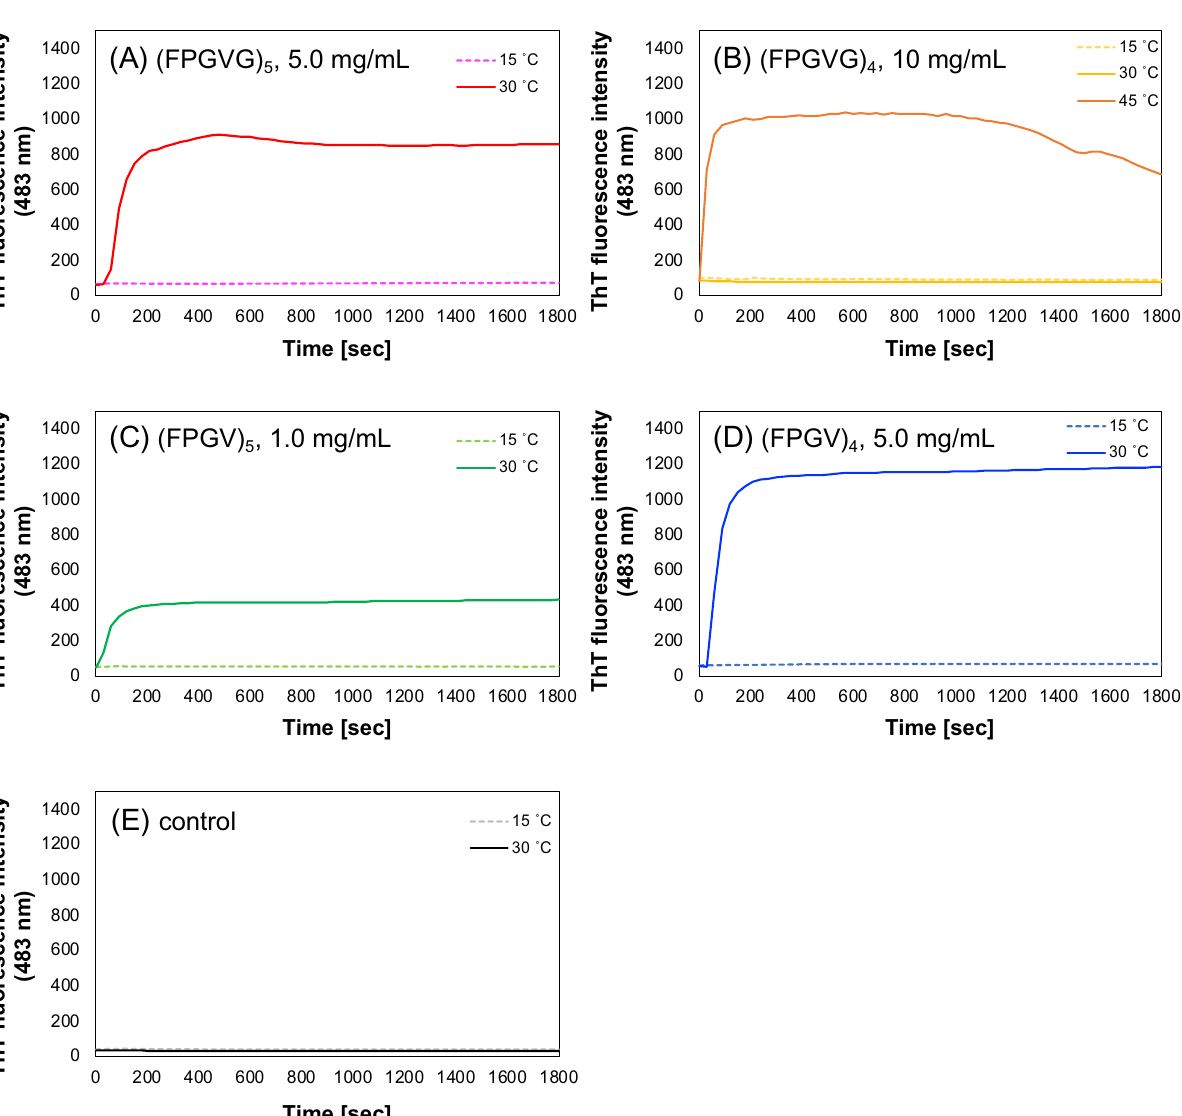
Figure 5. Time-lapse ThT fluorescence assay of truncated ELP analogues. Time-lapse ThT fluorescence assay monitoring below and above the T t . ( A ) (FPGVG) 5 (5 mg/mL), ( B ) (FPGVG) 4 (10 mg/mL), ( C ) (FPGV) 5 (1 mg/ mL), ( D ) (FPGV) 4 (5 mg/mL), and ( E ) control (no peptide included). Each peptide was dissolved in phosphate buffer (27.4 mM Na 2 HPO 4 , 17.8 mM NaH 2 PO 4 , pH 7.4) and ThT was added at a final concentration of 50